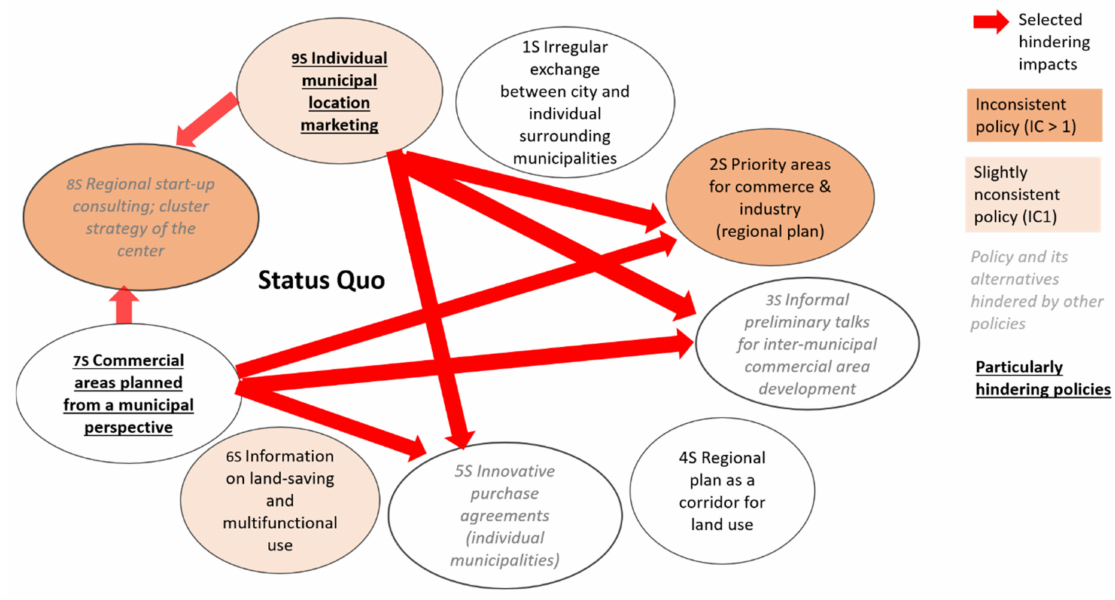
Figure 2. The status quo policy mix in PFENZ: inconsistent policies and hindering effects by municipal approaches to planning and marketing.